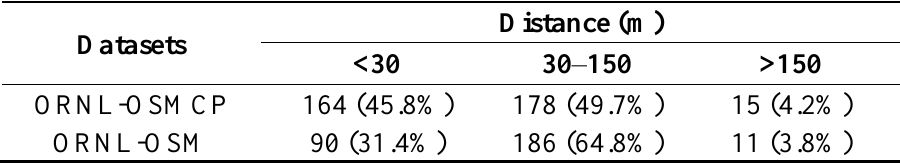
Table 6. Percent of schools with spatial error in each